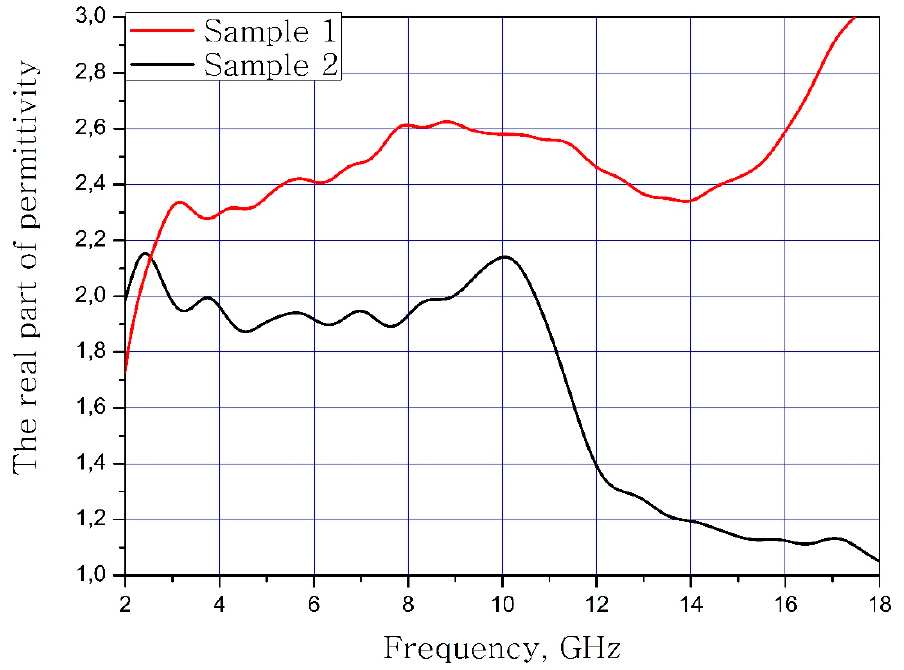
Nanomaterials 2019 , 9 , x FOR PEER REVIEW Figure 3. Frequency dependence of the real part of the dielectric permittivity of the samples.